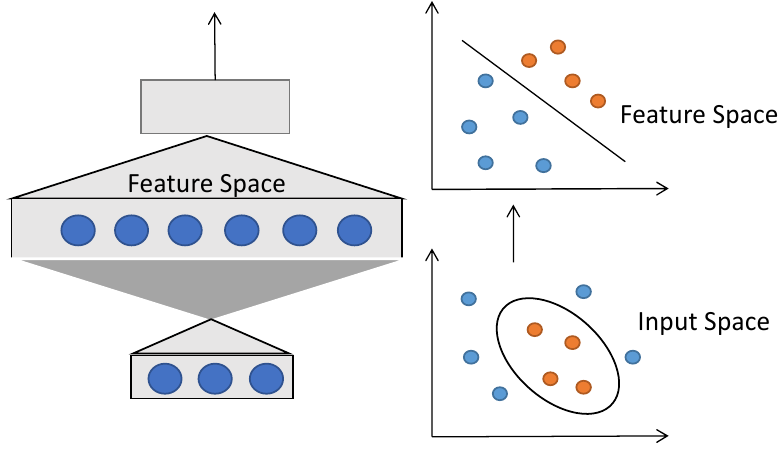
Figure 1. Support Vector Machine Mapping Schematic.